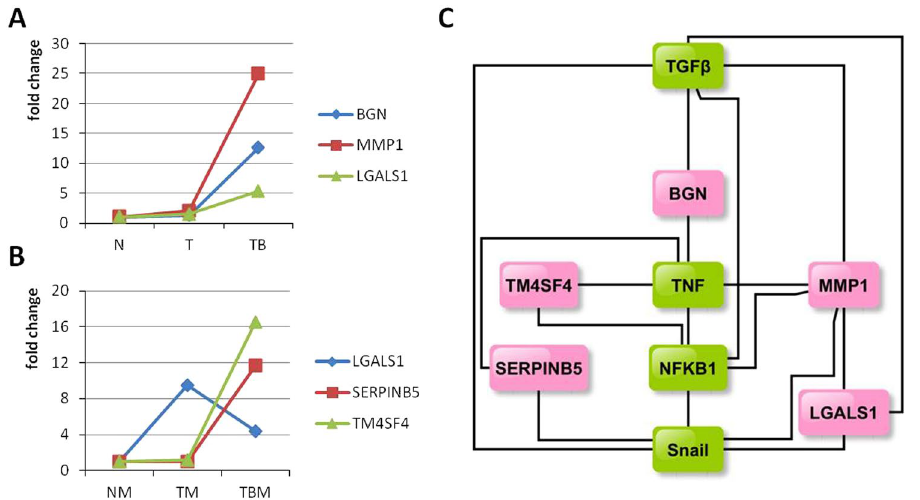
Figure 7. The regulatory relationships of candidate genes with the integrated pathway of TGF β /Snail with TNF α /NF κ B. ( A ) The expression levels of BGN, MMP1, and LGALS1 in IEC (N), CCPT (T), and tumor buds (TB). BGN, MMP1, and LGALS1 were upregulated in tumor bud cells. ( B ) The expression of LGALS1, SERPINB5, and TM4SF4 in the stromal cells of IEC (NM), CCPT (TM), and tumor buds (TBM). SERPINB5 and TM4SF4 were upregulated in TBM whereas LGALS1was downregulated, compared with the expression in NM and TM. ( C ) The candidate genes were functionally involved in the integrated pathway of TGF β /Snail with TNF α /NF κ